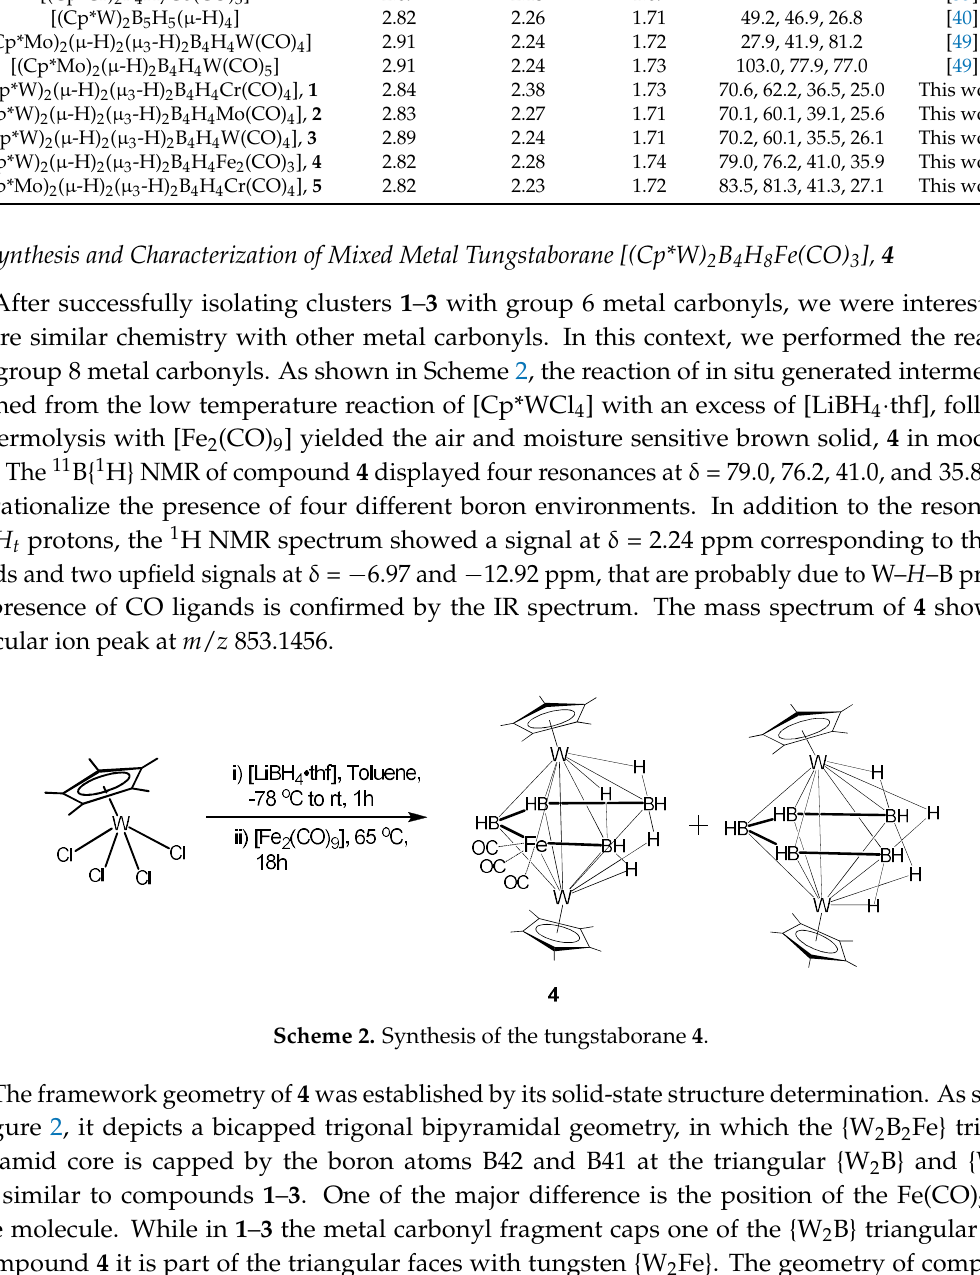
Figure 2. Molecular structure and labeling diagram of 4 . Selected bond lengths (Å) and bond angles ( ο ) W1–W2 2.816(4), W1–Fe1 2.667(10), W2–Fe1 2.702(9), W1–B41 2.377(7), W1–B43 2.175(7), W2–B41 2.355(7), W2–B44 2.208(7), B42–B43 1.751(12), B43–B44 1.723(10), Fe1–B44 2.067(7); W1–Fe1–W2 63.28(2), W2–B41–W1 73.1(2), B41–Fe1–B44 97.4(3), B42–B43–B44 124.0(6), Fe1–B44–B43 131.4(5). The framework geometry of 4 was established by its solid-state structure determination. As shown in Figure 2, it depicts a bicapped trigonal bipyramidal geometry, in which the {W 2 B 2 Fe} trigonal bipyramid core is capped by the boron atoms B42 and B41 at the triangular {W 2 B} and {W 2 Fe} faces similar to compounds 1 – 3 . One of the major difference is the position of the Fe(CO) 3 unit in the molecule. While in 1 – 3 the metal carbonyl fragment caps one of the {W 2 B} triangular faces, in compound 4 it is part of the triangular faces with tungsten {W 2 Fe}. The geometry of compound 4 resembles that of the tungsten-ruthenium complex [(Cp*W) 2 B 4 H 8 Ru(CO) 3 ] [33] where Ru(CO)